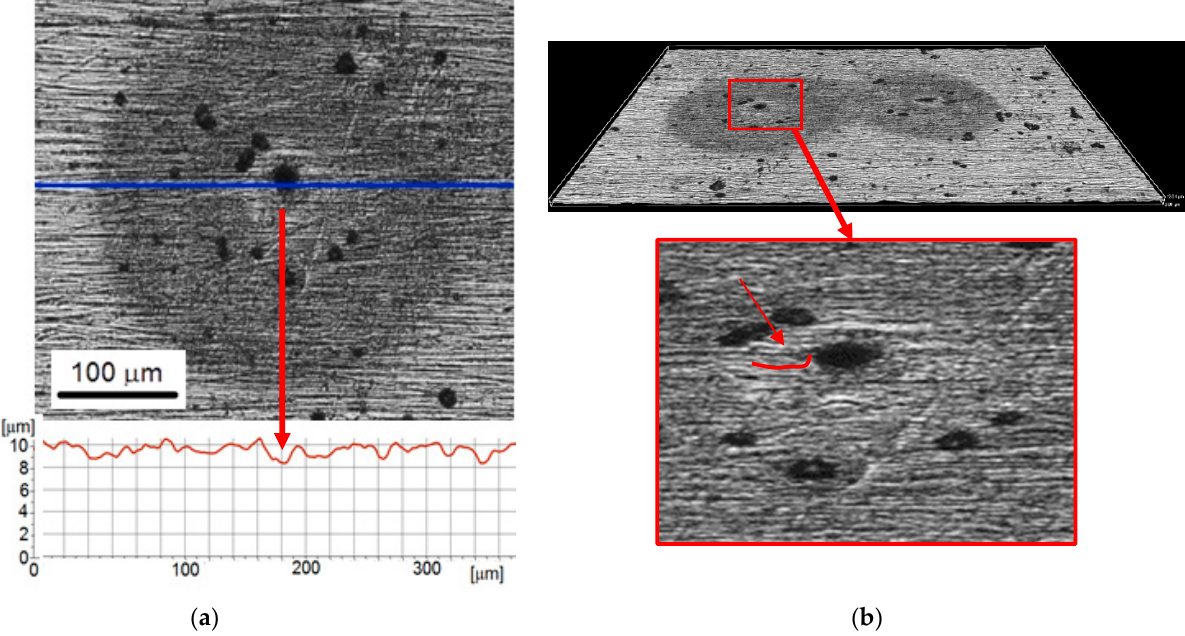
Figure 8. Nickel coating after 30 min of the cavitation erosion tests: ( a ) surface morphology with roughness profile along the selected measurement line; ( b ) 3D surface profile.